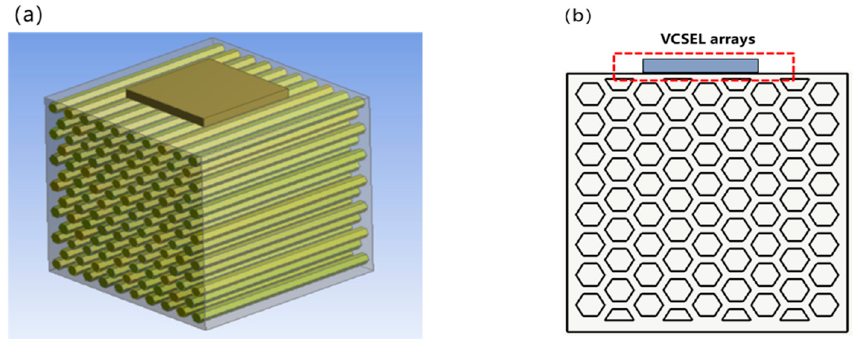
Figure 3. ( a ) Honeycomb microchannel cooling system model. ( b ) Schematic diagram of the cross- sectional structure of the honeycomb microchannel front view.